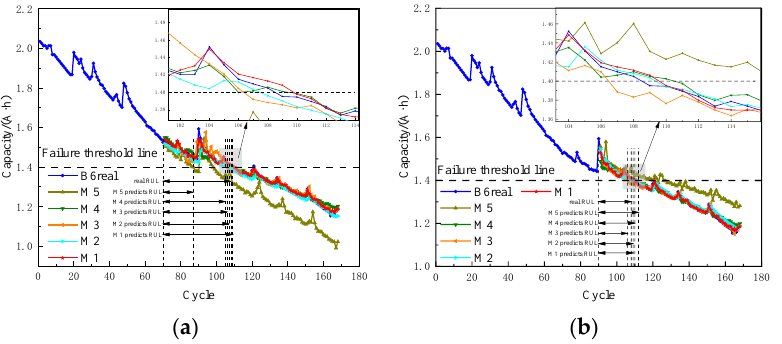
Figure 12. Prediction results of the B5 battery. ( a ) Prediction starting point: 70. ( b ) Prediction starting point: 90.